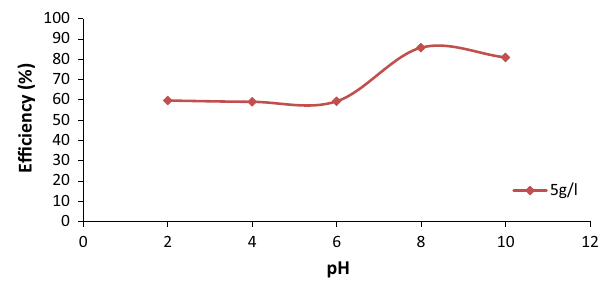
Fig. 6 The plot of pH effect at 5 g/L coagulant dosage and varying pH values